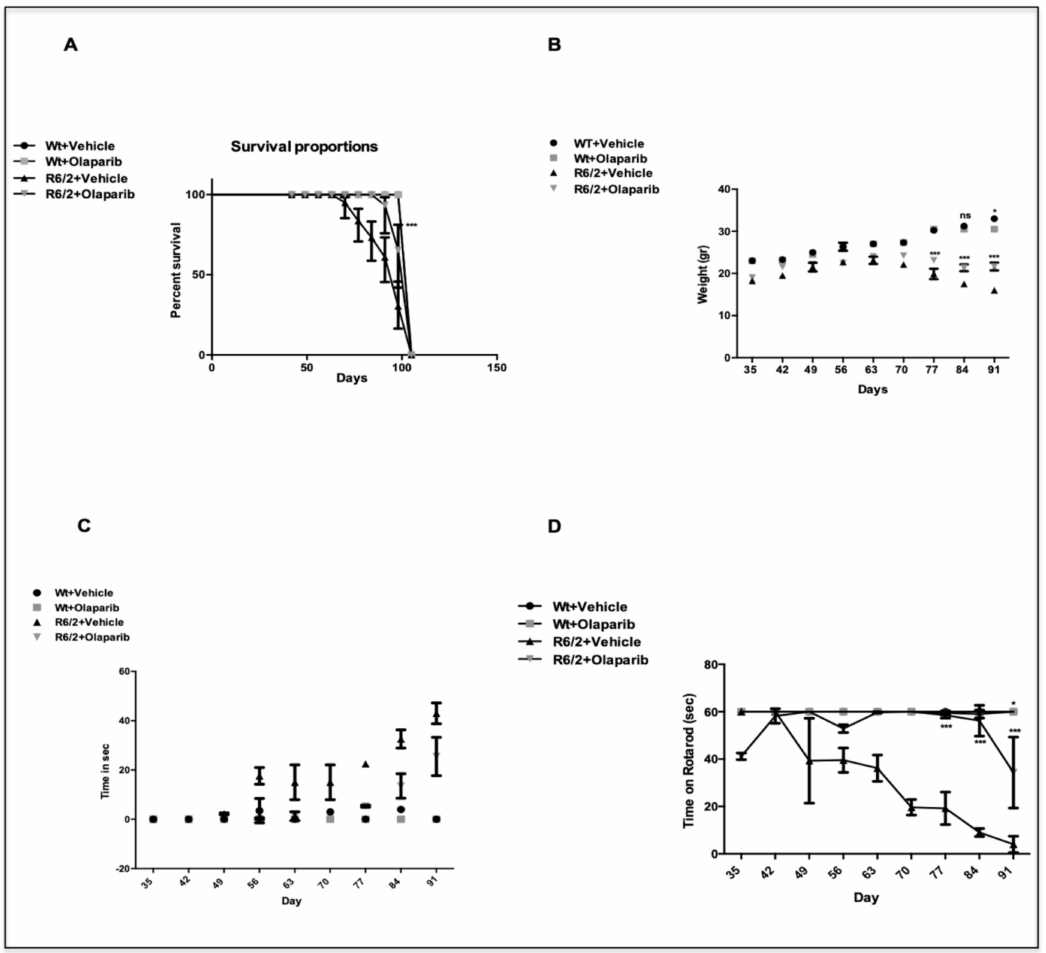
Figure 1. Secondary outcome measures. In ( A ), a Kaplan–Meier curve of survival is represented. R6 / 2 mice treated with Olaparib showed a mean survival time that was significantly longer ( p < 0.0001) than that of R6 / 2 mice treated with vehicle. ( B ) Olaparib e ff ects on wild type and R6 / 2 mice weight. A three-way ANOVA shows a statistically significant e ff ect of Genotype (F 1,32 = 45.8; p < 0.0001), Time (F 8,250 = 86.24 p < 0.0001), and Genotype X Treatment X Time interaction (F 8,250 = 12.78 p < 0.000) in R6 / 2 mice treated with Olaparib ( C ). Hind-limb clasping phenotype in R6 / 2 mice treated with Olaparib. Data analysis indicates a statistically significant e ff ect of treatment and time. Olaparib-treated R6 / 2 mice showed significantly less clasping at weeks 11,12, and 13 (*** p < 0.001). ( D ) A three-way ANOVA with genotype, treatment, and time as main factors, revealed that R6 / 2 mice had a statistically significant impairment in motor coordination with respect to wild-type mice (F 1,36 = 59.39 p < 0.0001) and that Olaparib treatment improves performance in a genotype-dependent fashion (F 8,288 = 6.03; p <